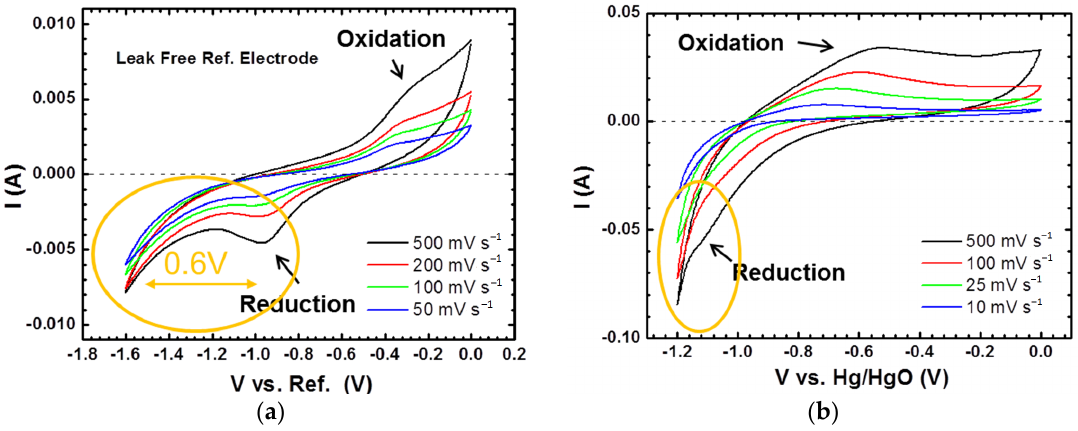
Figure 7. Cyclic voltammograms of Ni/MH half-cells using ( a ) 2 M acetic acid in [EMIM][Ac] as an electrolyte and ( b ) the 30 wt% KOH aqueous electrolyte.